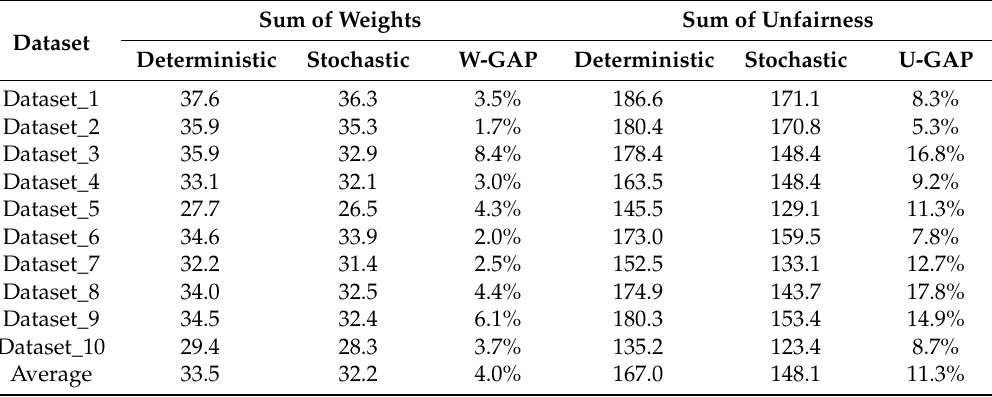
Table 2. Comparison of the two models in terms of total weight and total unfairness.